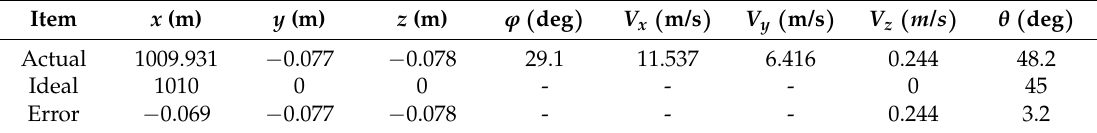
Table 4. Comparison between the actual state of the helicopter and the ideal state.